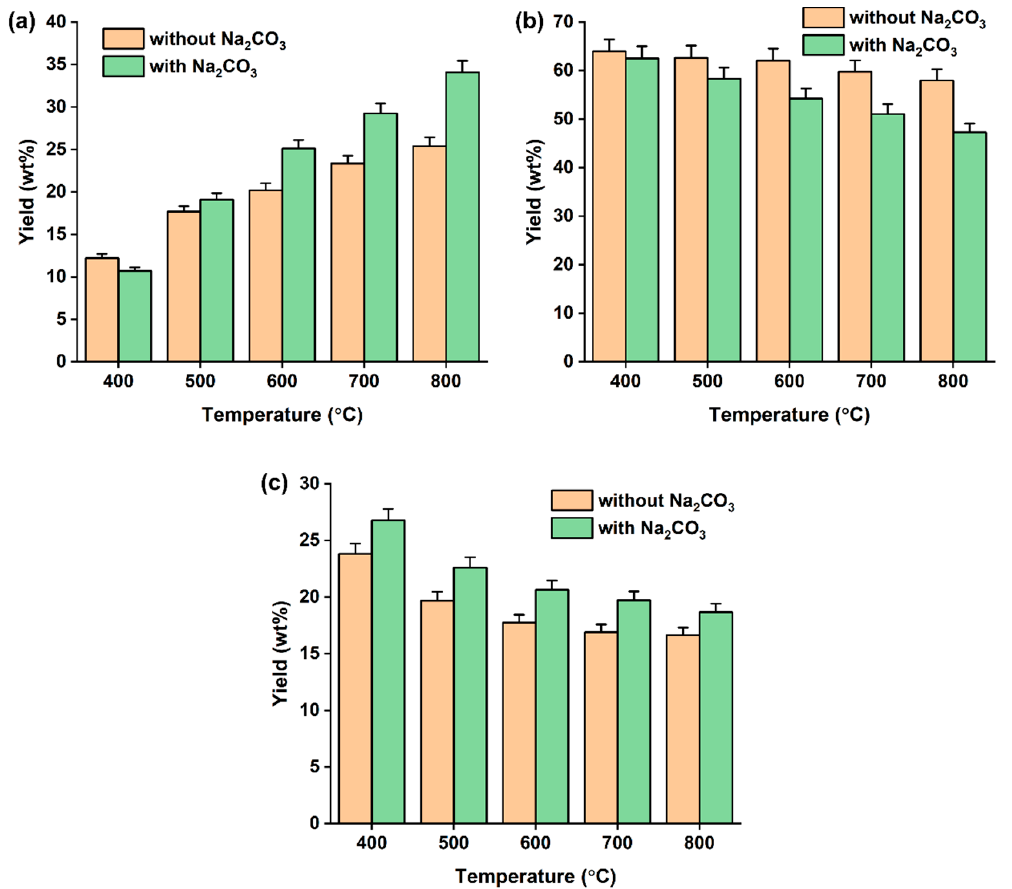
Figure 3. The yield of pyrolysates made from DJW with and without Na 2 CO 3 at varied pyrolysis temperatures: ( a ) gas phase pyrolysate, ( b ) liquid phase pyrolysate, and ( c ) solid phase pyrolysate. Average values of triplicate are reported with standard deviations given as error bars.